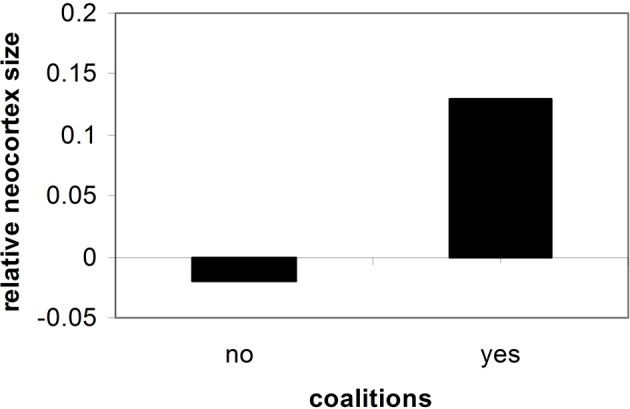
Neocortex size and social cooperation (Dunbar and Shultz, 2007).